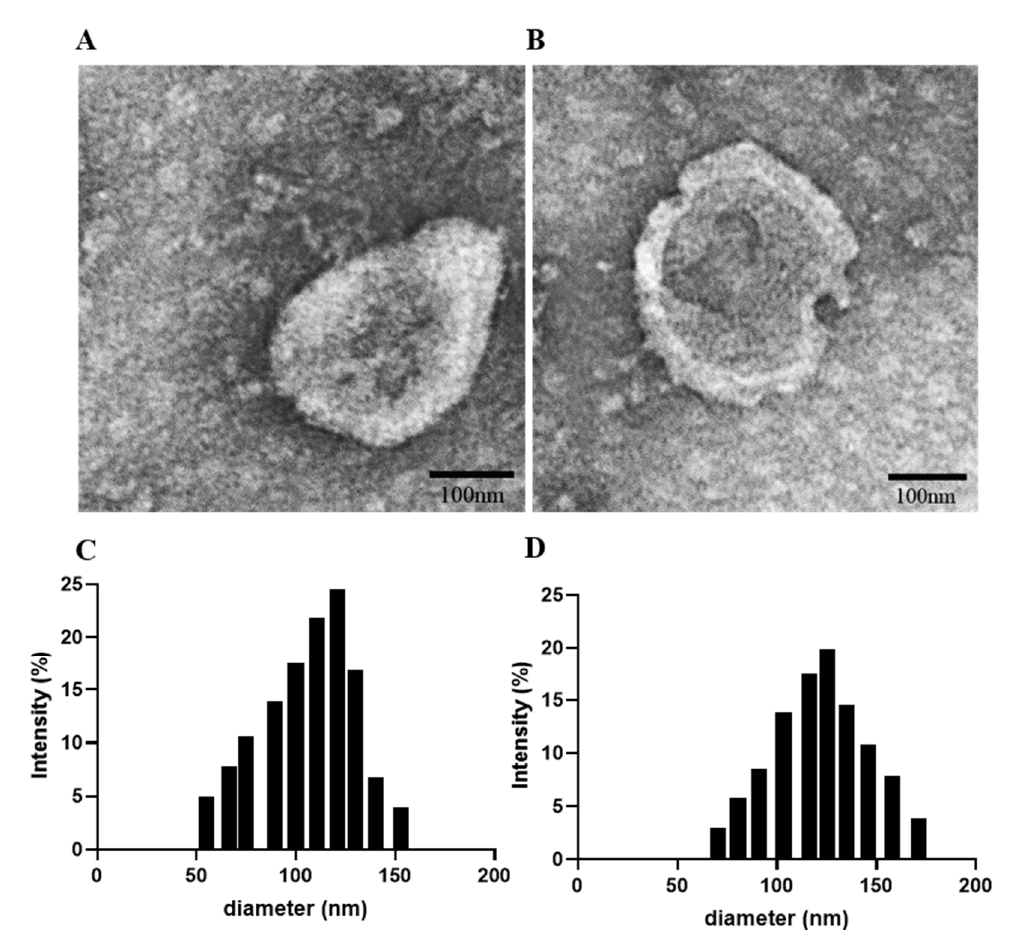
Figure 1. Characterization of M1Exo with or without drug loading: TEM images of ( A ) M1Exo and ( B ) M1Exo-GEM-DFX and the TEM particle size data which were converted directly to cumulative number-based distributions, ( C ) M1Exo, and ( D ) M1Exo-GEM-DFX.